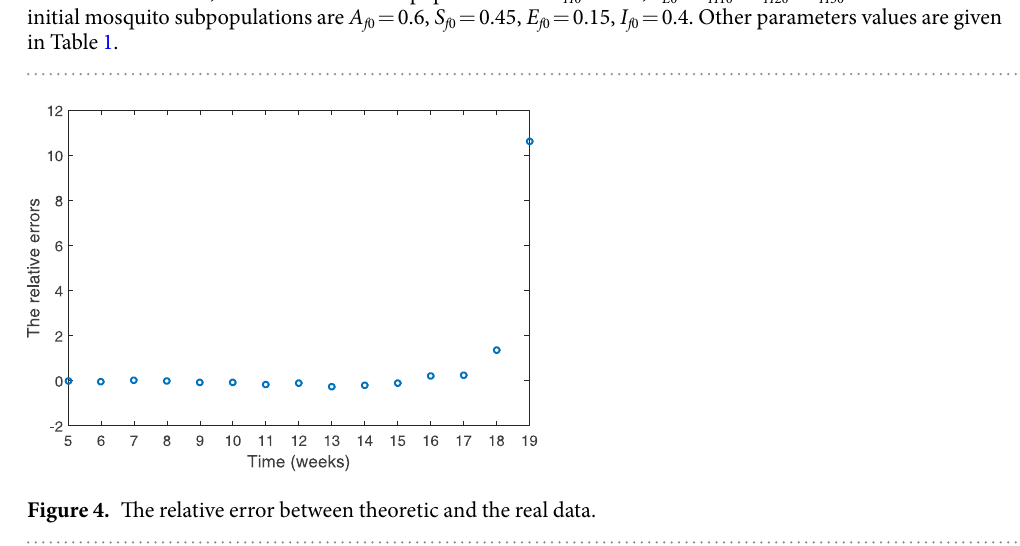
Figure 3. The fitting results of new suspected human cases from the 5th week to 19th week in 2016 and prediction result for the following 15 weeks. After the populations of both humans and mosquitoes are nondimensionalised, the initial human subpopulations are S H 0 = 0.58, S E 0 = I H 10 = I H 20 = I H 30 = 0.0025. The initial mosquito subpopulations are A